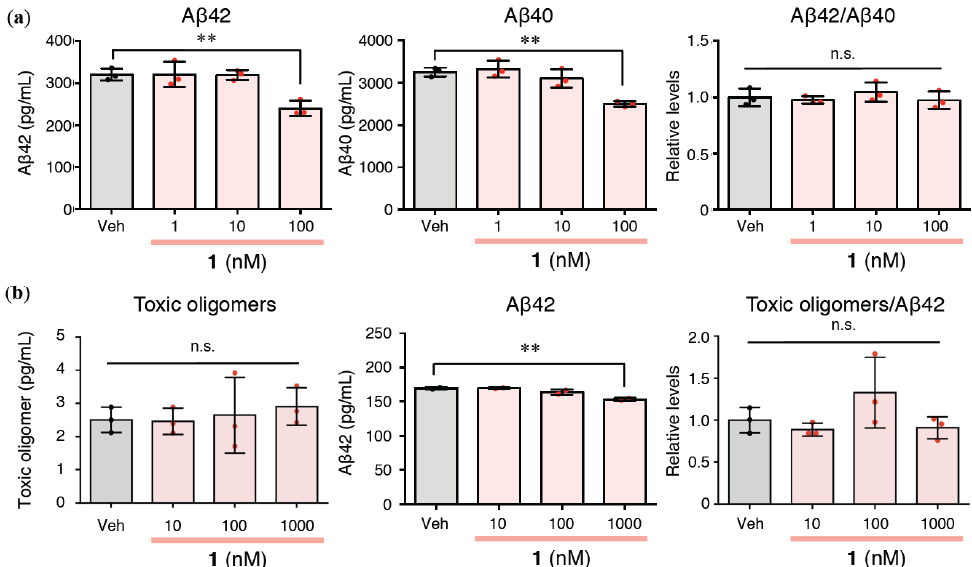
Figure 2. ( a ) Monomeric A β 42, A β 40, and their ratio (A β 42/A β 40) in the conditioned medium of rat primary cerebral cortex cells treated with 1 at the indicated concentrations for 24 h. ( b ) Toxic A β oligomers, monomeric A β 42, and their ratio (toxic oligomers/A β 42) in the conditioned medium of rat primary cerebral cortex cells treated with 1 at the indicated concentrations for 6 h. The data are presented as mean ± SD ( n = 3). ** p < 0.01 versus Veh (vehicle). n.s.: not significant. Red or black dots represent each value.